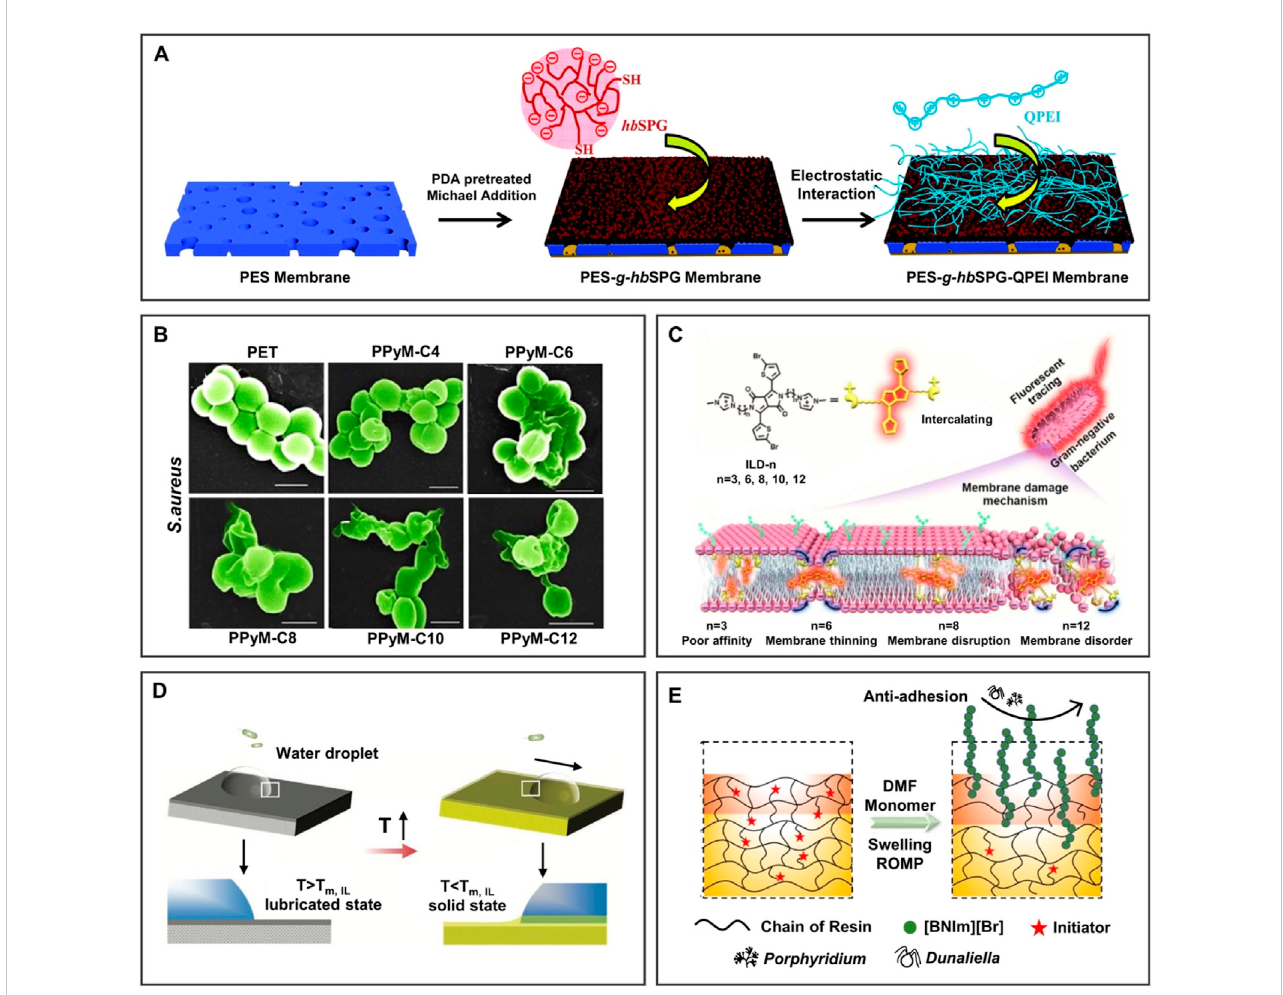
FIGURE 6 BILIMs for anti-biofouling. (A) PILs modi fi ed membrane decreased the adsorption of protein obviously after soaking in wastewater for 2 months. Reproducedwithpermission(Lietal.,2019).Copyright2019,TheRoyalSocietyofChemistry. (B) Antibacterialef fi ciencyofPILsagainstGram-positivebacteria increasedwiththeincreaseofthealkylchainlengthofsubstituentsbecauseofhydrophobicsegmentsinsertedintobacterialmembranes,leadingtobacterial death. Reproduced with permission (Qin et al., 2017). Copyright 2017, American Chemical Society. (C) The antibacterial ef fi ciency of pyrrolidinium-type IL against Staphylococcus aureus increases with the increase of the alkyl chain length of substituents, resulting in instability of the lipid bilayer and